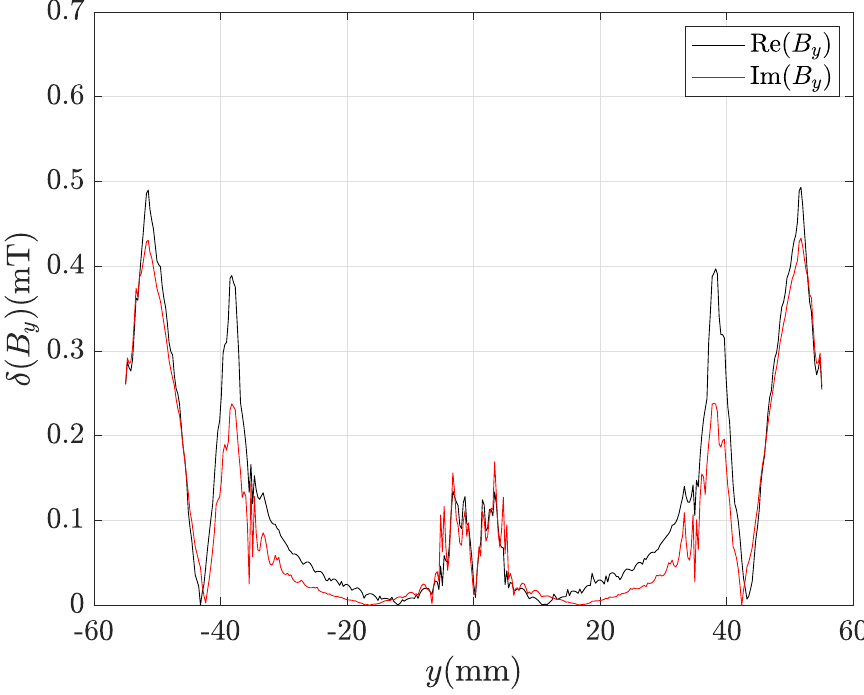
Figure 17. Local discrepancy between CM-BEM and FEM profiles of component B y in Figure